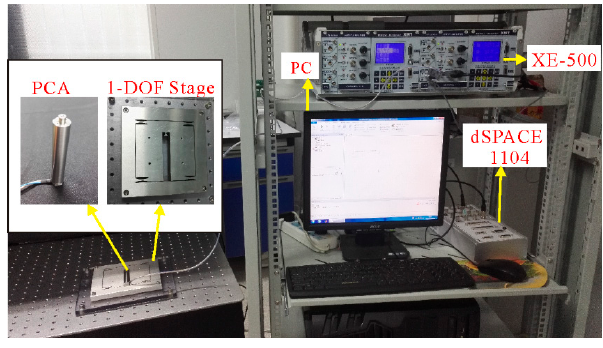
Figure 7. Experimental setup. Table 2. Information about the piezoelectric ceramics actuator